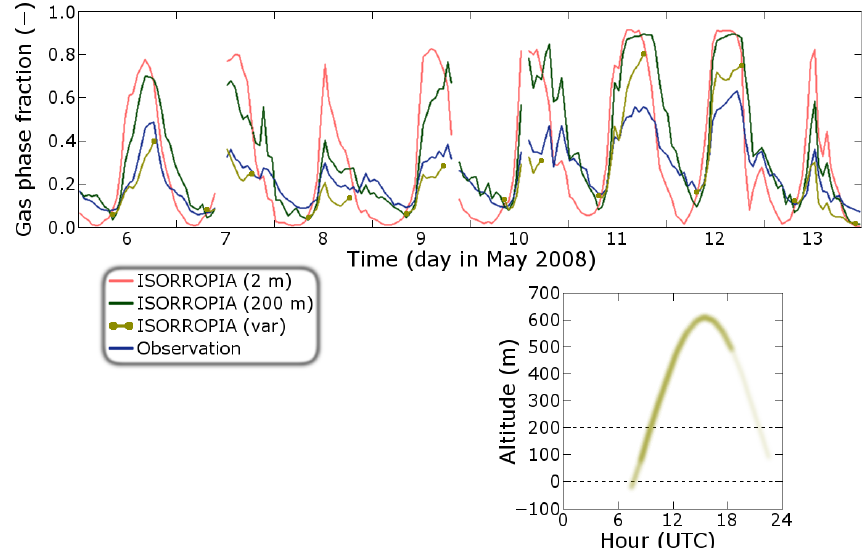
Fig. 10. Upper panel: calculated equilibrium gas phase fraction of nitrate using observations of total ammonium, total nitrate and sulphate, using temperature and relative humidity at 2m, at 200m, and at varying altitude (only for unstable conditions), and observed gas phase fraction of nitrate, in the period 6–13 May 2008. Lower panel: altitude as function of time of the day used for the varying-altitude calculation. The thickness of the line represents the number of days at which the conditions were unstable at that